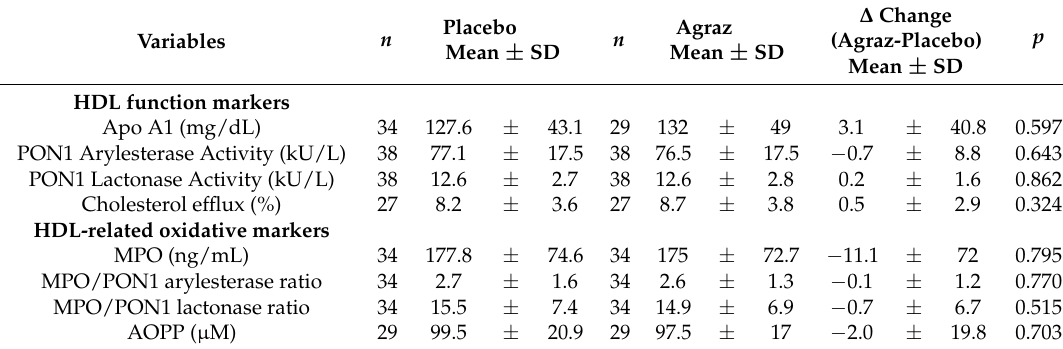
Table 2. High-density lipoprotein (HDL) function markers after 4 weeks of agraz consumption, compared to placebo, in women with metabolic